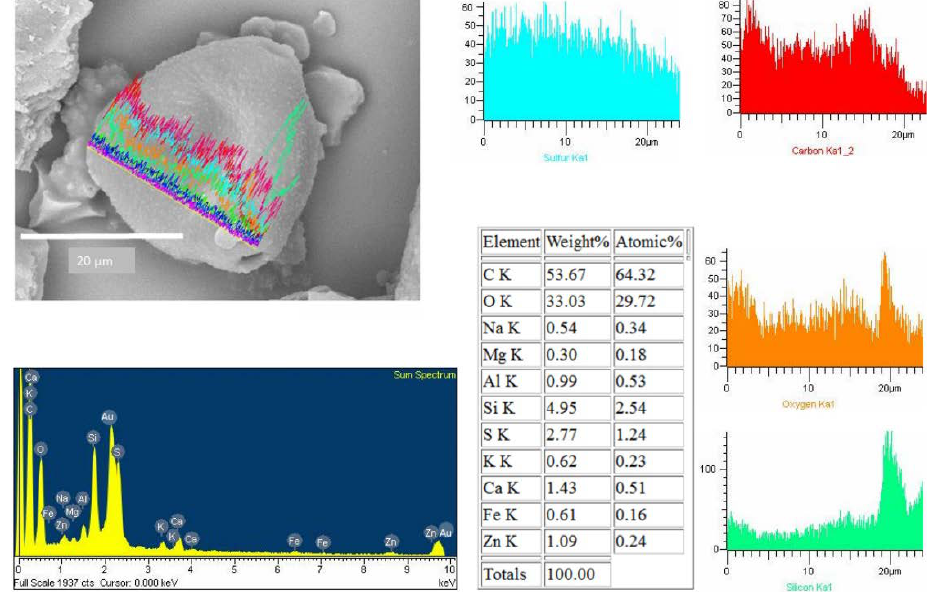
Figure11. Iron particles with different morphologies. ( a ) Layer, ( b ) EDX spectrum, ( c ) rhomboid and ( d ) agglomerate.